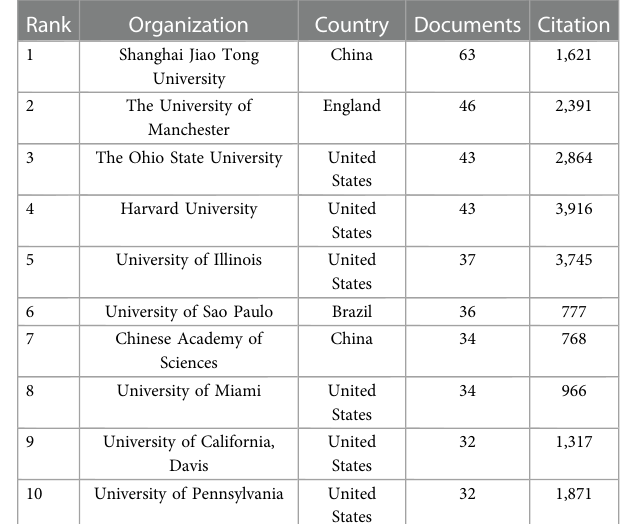
TABLE 4 The top 10 productive institutions.